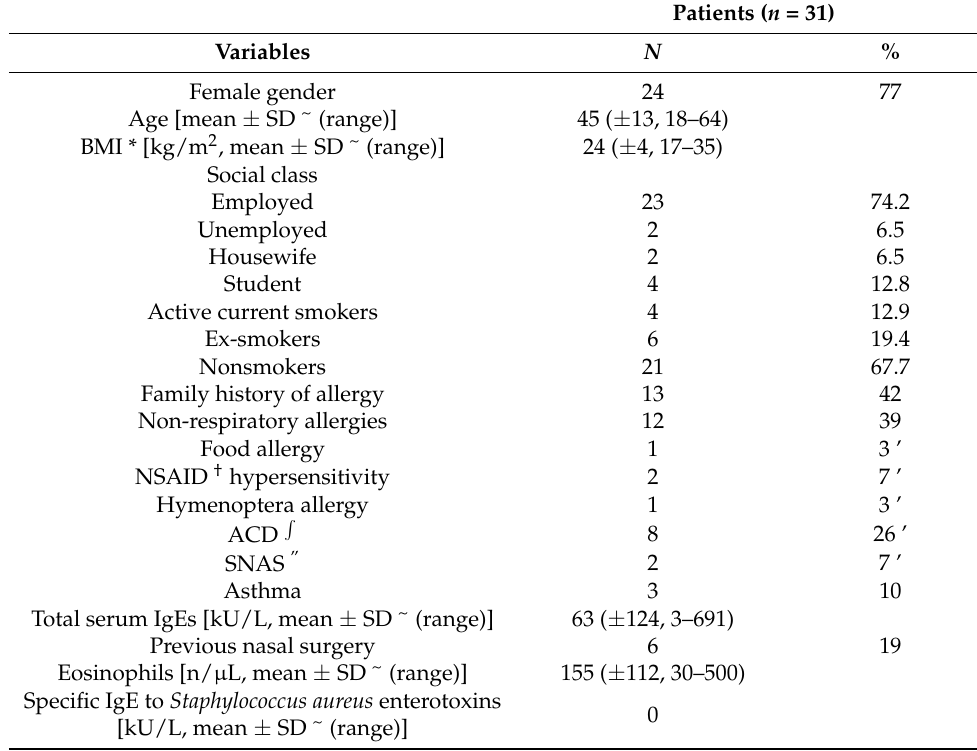
Table 1. The baseline socio-demographics and clinical characteristics of the